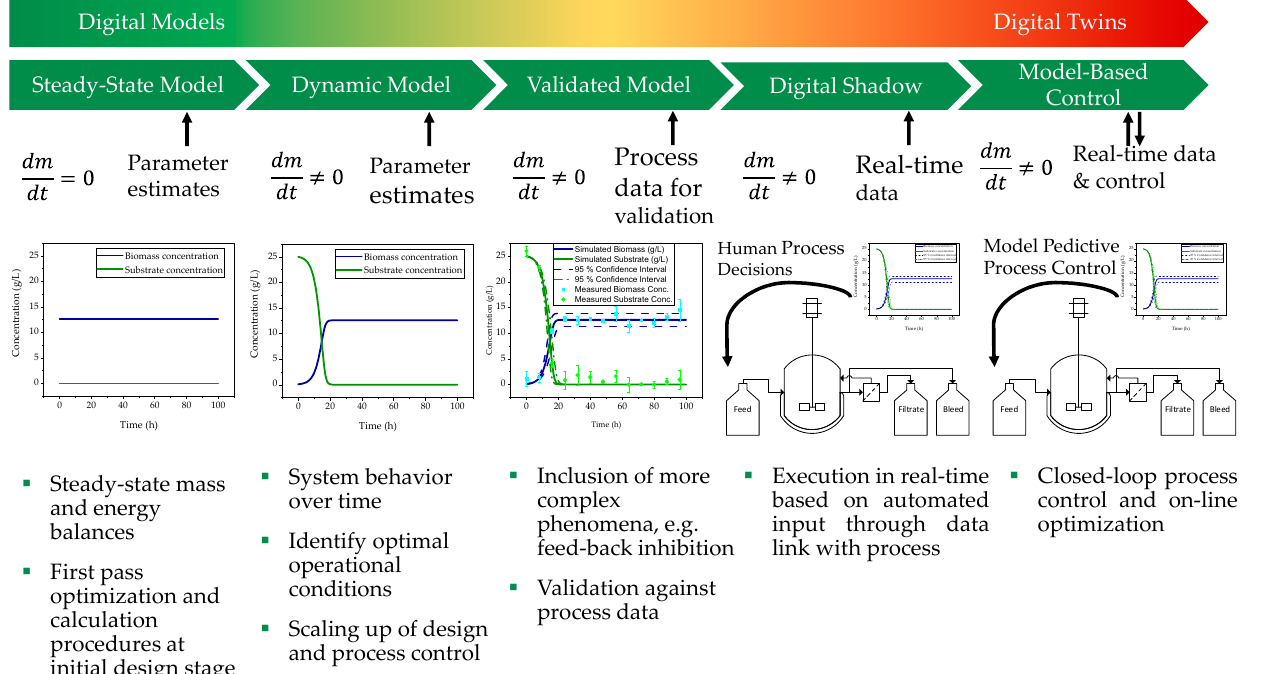
Figure 2. Levels of a digital twin, starting from a steady-state-model, over a dynamic model, a validated model, and a digital shadow to a model-based control